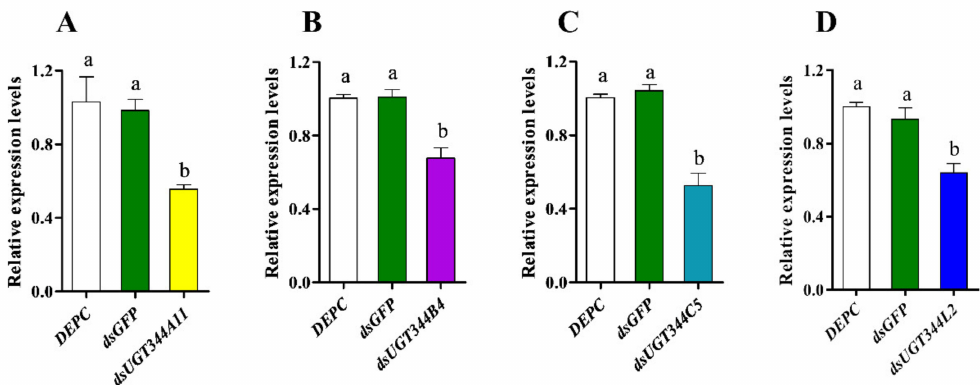
Figure 2. The transcription levels of UGT genes in Aphis gossypii fed with corresponding dsRNA (100 ng µ L − 1 ). The transcription levels of UGT344A11 ( A ), UGT344B4 ( B ), UGT344C5 ( C ), and UGT344L2 ( D ) in A. gossypii . The DEPC water and dsGFP (100 ng µ L − 1 ) treatments were used as control. Different lowercase letters (a, b) with the bars indicated that the means are significantly different according to one-way ANOVA, followed by Tukey’s multiple comparison test ( p < 0.05).